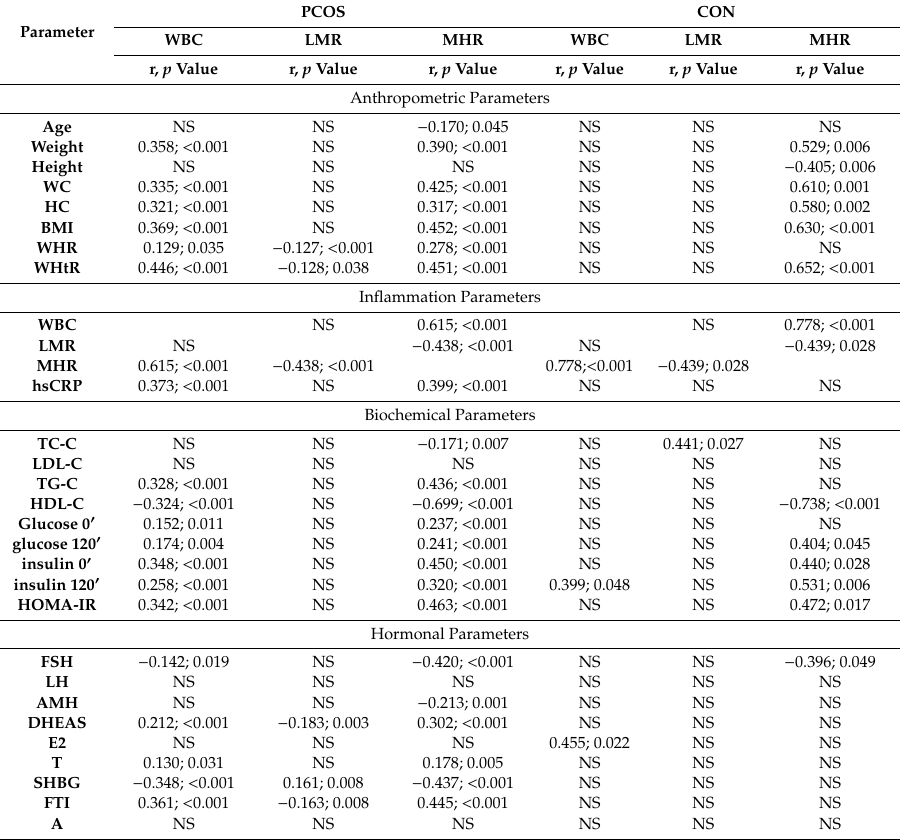
Table 6. Pearson’s linear correlation analysis of complete blood count inflammatory markers in PCOS and CON